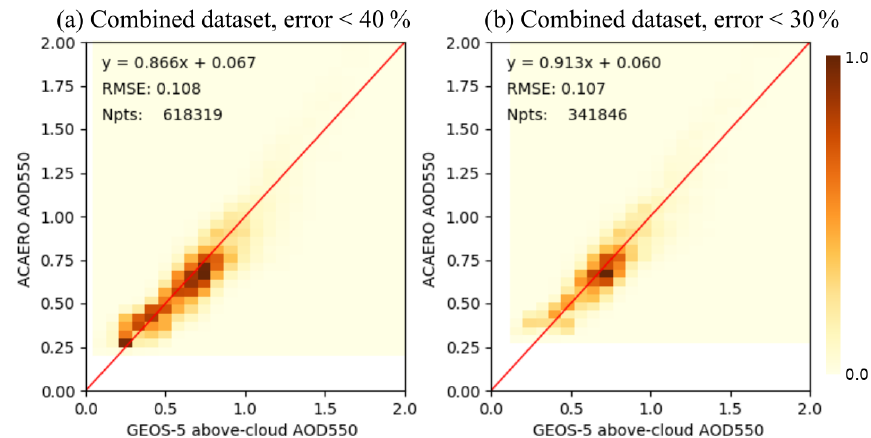
Figure 8. MOD06ACAERO retrieval results from the combined dataset of Fig. 3a compared to source GEOS-5 aerosol optical depth as a normalized density plot. AOD retrievals where COT was less than 4 and where the scattering angle was in the cloud bow are now discarded. Additionally the data extent had been limited to only include pixels with view zenith angle of less than 32 ◦ . Retrieval comparison shows further improvement. Panel (a) shows MOD06ACAERO retrievals with uncertainty of less than 40%, and panel (b) shows the same with uncertainty less than 30%.